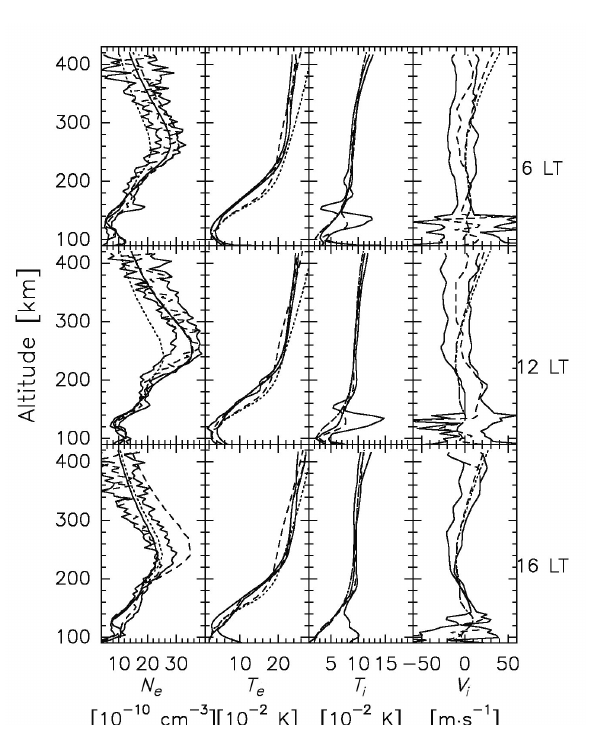
Fig. 4.2. The four upper panels are the ionospheric profiles at 6 LT, the middle panel at 12 LT and the bottom panels at 16 LT. From left to right, one gets the electron density, electron temperature, ion temperature, ion ve- locity parallel to B . The broken lines are the measurements with instantaneous values in dashed lines and the sur- rounding extreme values in full lines. The modeling outputs are in smoothed lines. The dashed lines stand for no correction factor in the neutral atmosphere. The dotted lines are with a correction factor of 0.7. The full line (in the electron density only) for a time varying correction factor. This factor’s values are 0.915 at 6 LT, 0.99 at 12 LT and 0.65 at 16